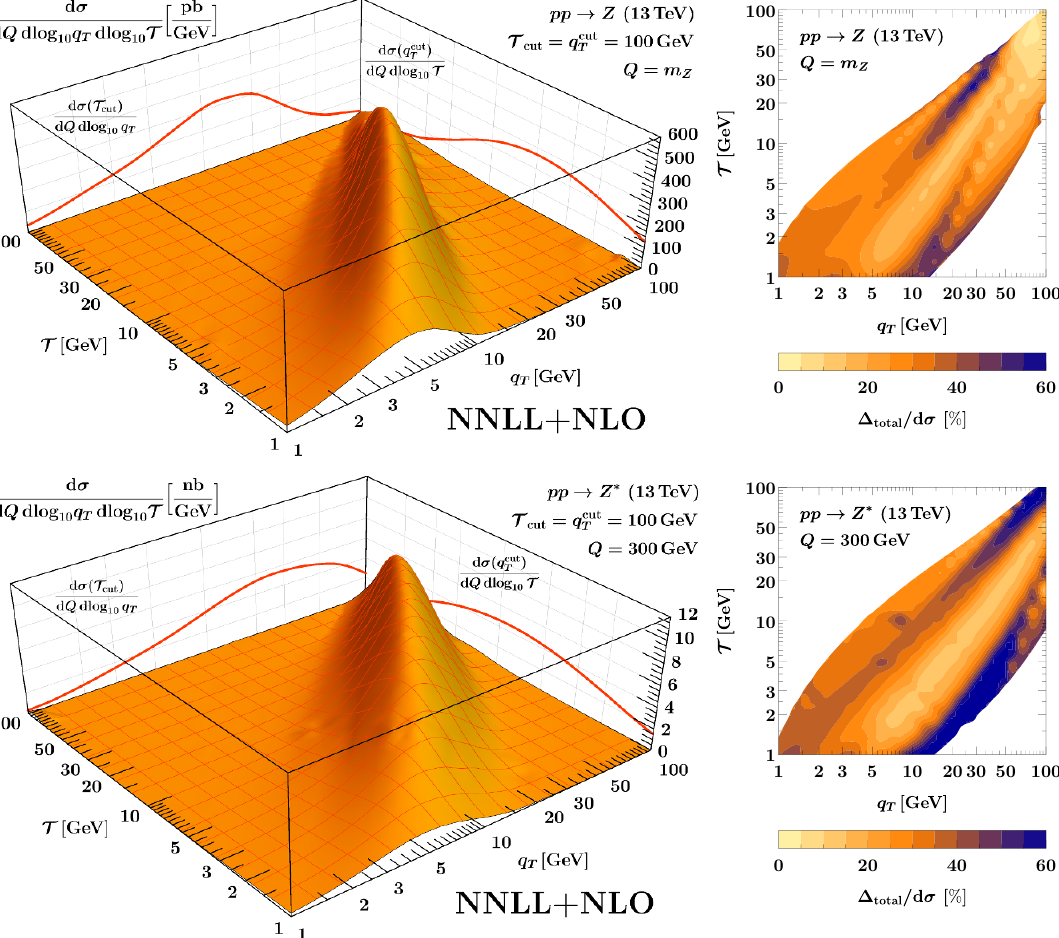
Figure 16 . The double-di(cid:11)erential Drell-Yan cross section at NNLL+NLO, at Q = m Z (top) and Q = 300 GeV (bottom), with respect to log of integrating the double spectrum over either variable up to a cut at 100 GeV. The contour plots indicate total perturbative uncertainties relative to the cross section, (cid:1) total = (cid:1) + (cid:8) (cid:1) I (cid:8) (cid:1) II (cid:8) (cid:1) FO . The contour plots are left blank in the region where d (cid:27)= (d Q d log its peak